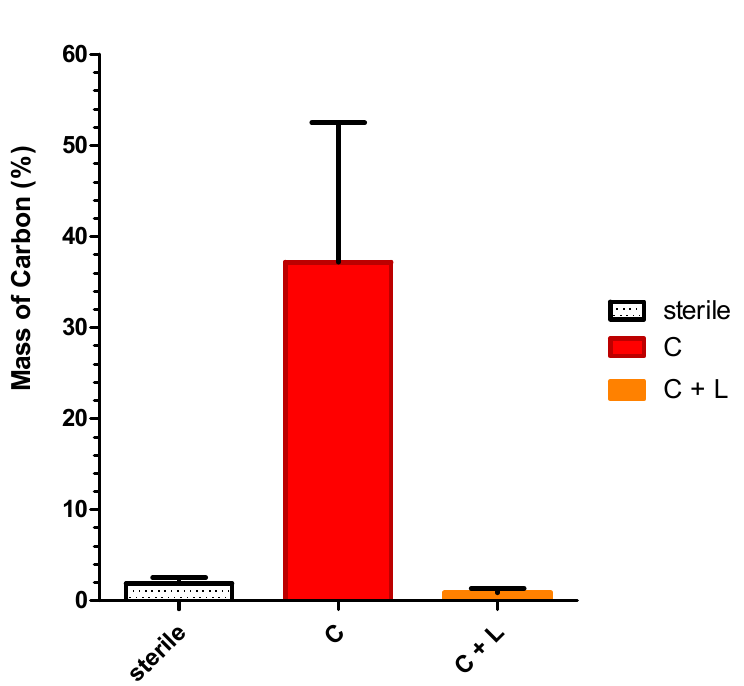
Figure 7. Percentage of mean of carbon mass (percentage) on implant surfaces in the S, C and L groups.